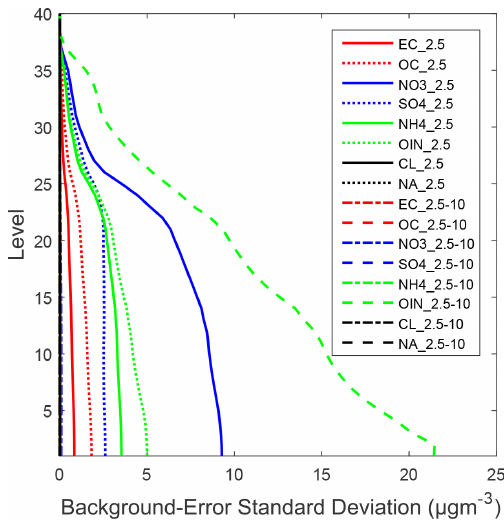
Figure 2. Vertical BESD profiles of the 16 control